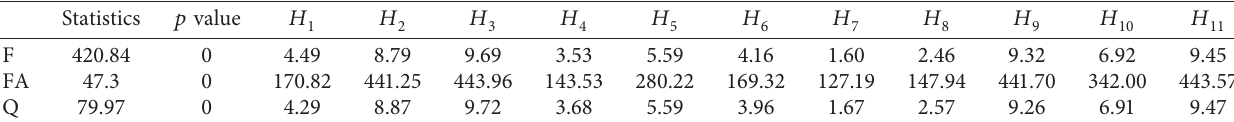
Table 11: Statistic test results for capacitated vehicle routing problem instances for Friedman (F), Friedman Aligned (FA), and Quade (Q).